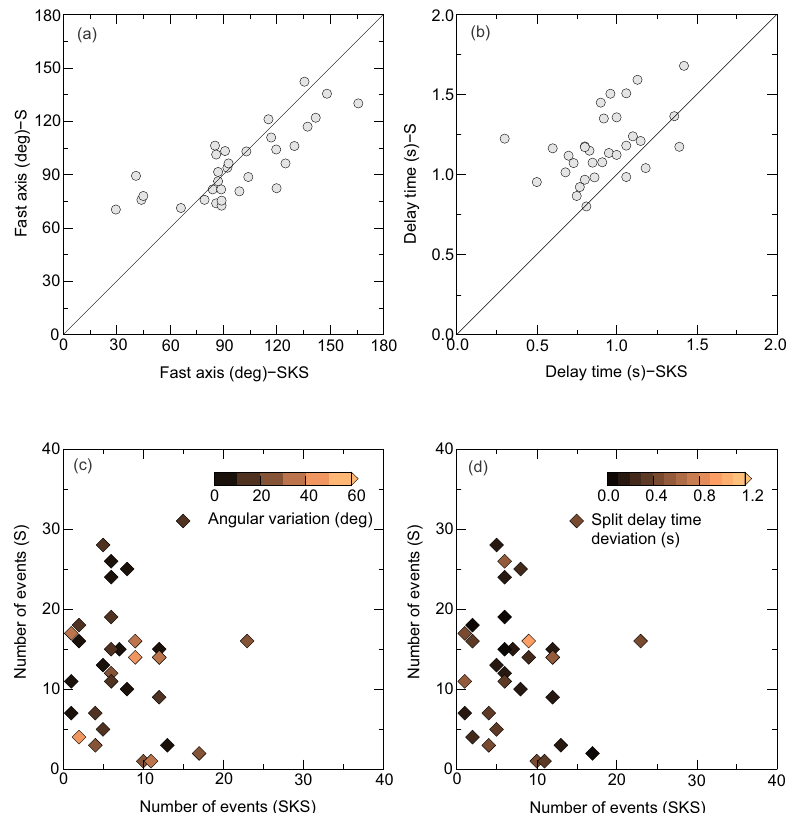
Figure 8. Comparison of SKS and S -wave-derived station-averaged splitting parameters in the study region. Panels (a) and (b) : scatter plots that compare SKS- and S -derived FPDs and split time delays (TDs), respectively. (c) Scatter plot of the number of individual SKS splitting measurement and the number of events used in direct S splitting measurement (this study). Note that each station here is colour-coded by its absolute deviation value that is obtained by subtracting S - and SKS-derived FPDs. (d) The same plot for the misfit between SKS- and S -derived station-averaged split TDs. Average SKS splitting parameters used in this figure are taken from Sol et al.